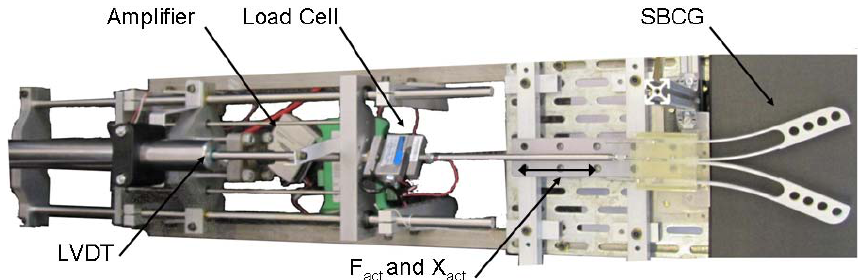
Figure 6. The top view of test set-up: the sti ff ness characteristic and force displacement of SBCG was determined by measuring actuation force (Fact; using a load cell) and displacement (Xact; using LVDT) during opening and closing of the SBCG.